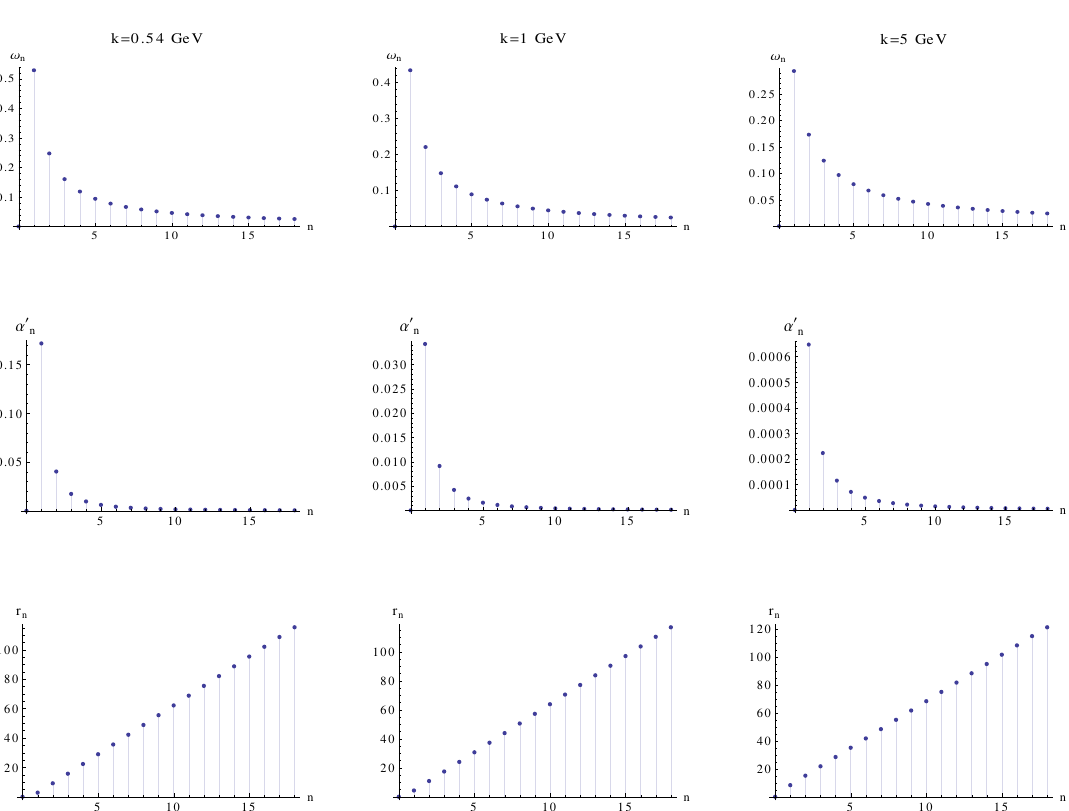
Figure 23 . Graphical illustration of table 4. First row: eigenvalues ! n vs. n . Second row: slopes (cid:11) 0 vs. n .Third row: radii r n vs. n . n